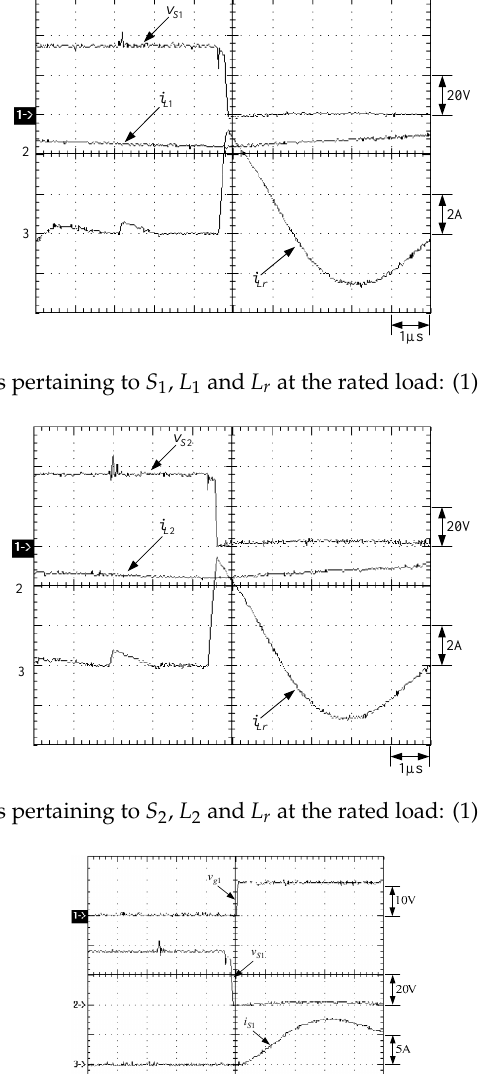
gb v Figure 26. Waveforms pertaining to S 2 and S b at the rated load: (1) v g 2 ; and (2) v gb . 5A 5V